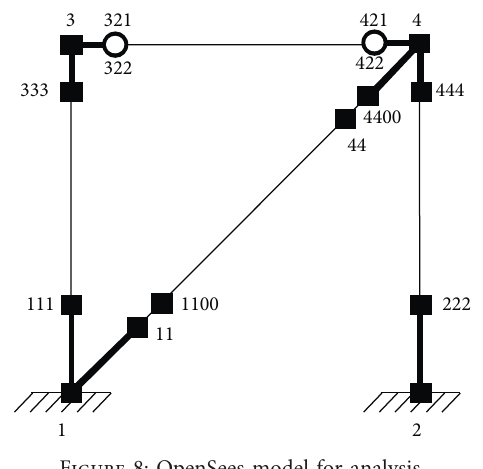
Figure 8: OpenSees model for